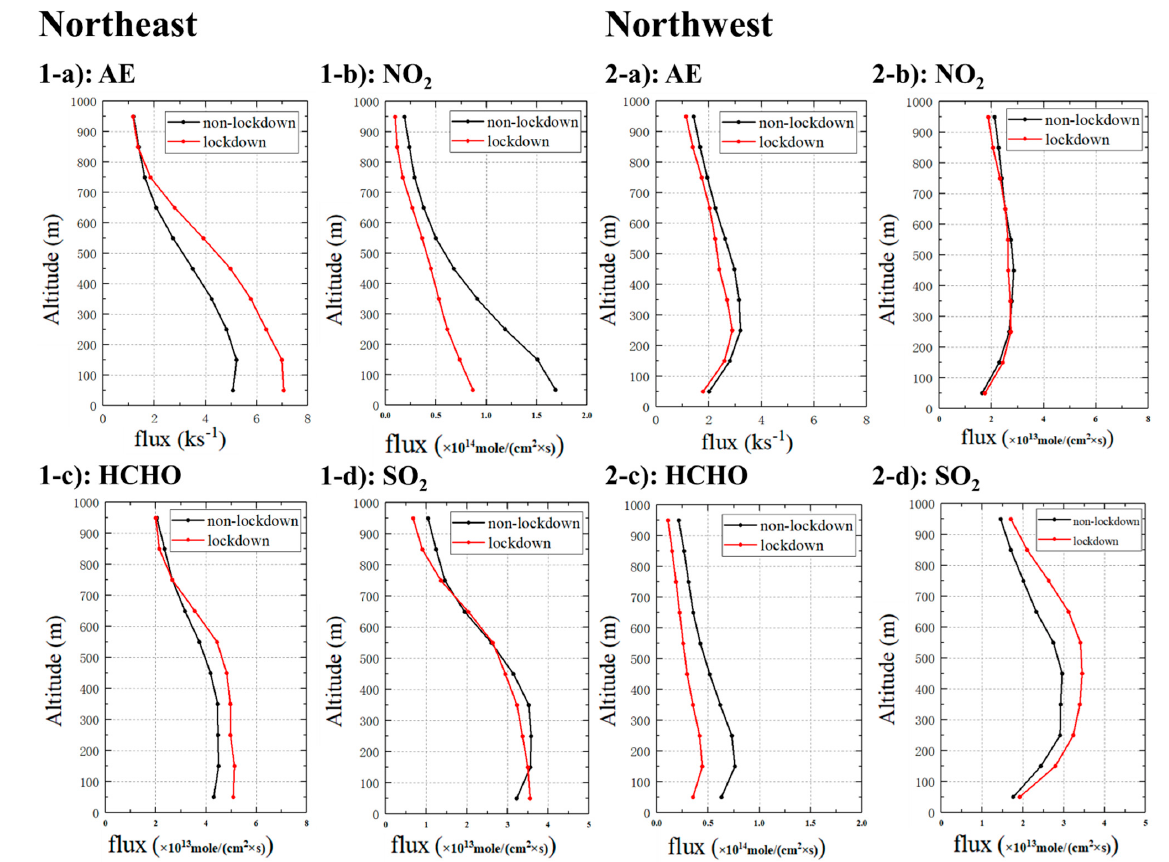
Figure 12. Vertical transport flux structure for the (1) northeast and (2) northwest directions during lockdown and non- lockdown period for ( a ) aerosol extinction, ( b ) NO 2 , ( c ) HCHO, ( d ) SO 2